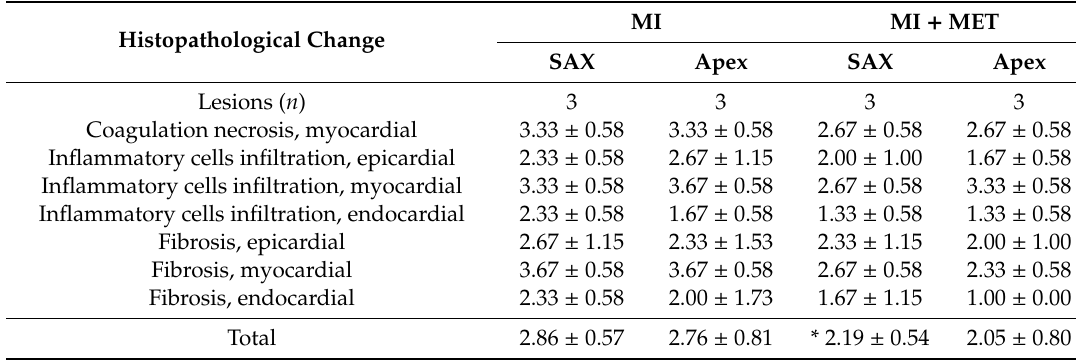
Table 2. Incidence of histopathological changes in the hearts of